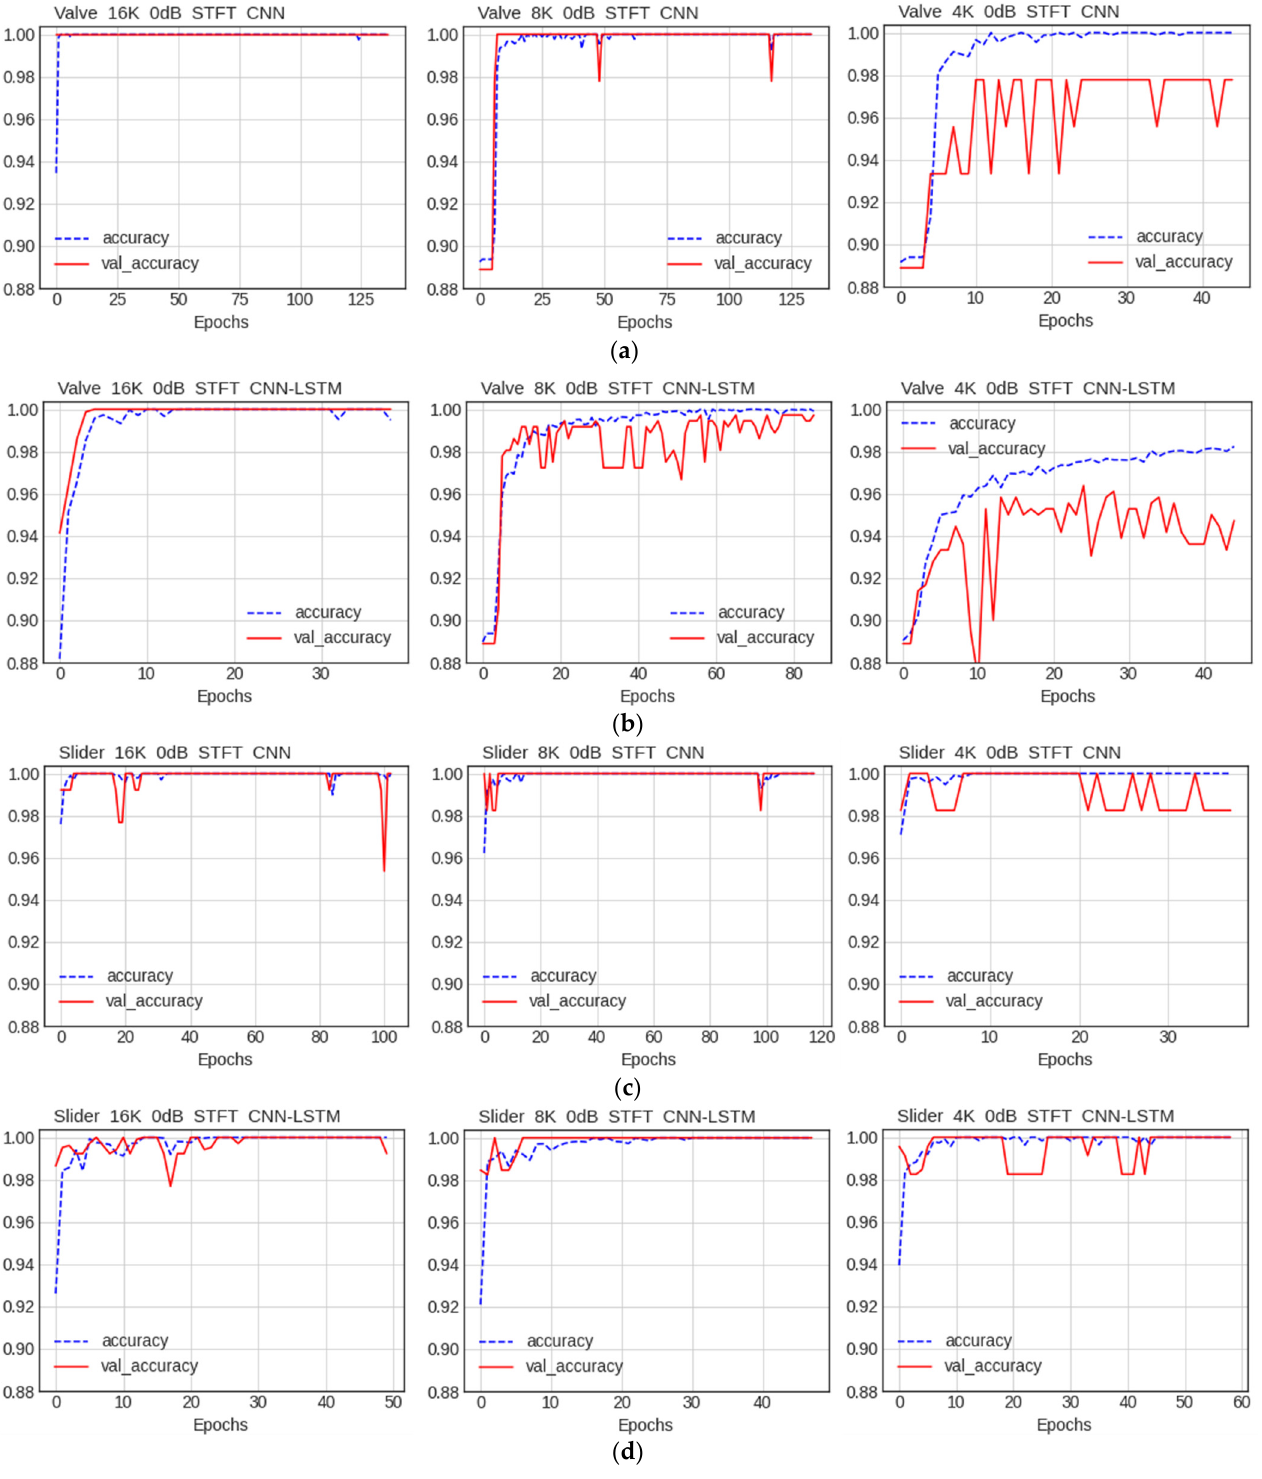
Figure 18. Accuracy of using data after preprocessing with the STFT after changing the data quality to 4 K, 8 K, and 16 K: ( a ) result of valve data training on the CNN model; ( b ) result of valve data training on the CNN–LSTM model; ( c ) result of slider data training on the CNN model; and ( d ) result of slider data training on the CNN–LSTM model.